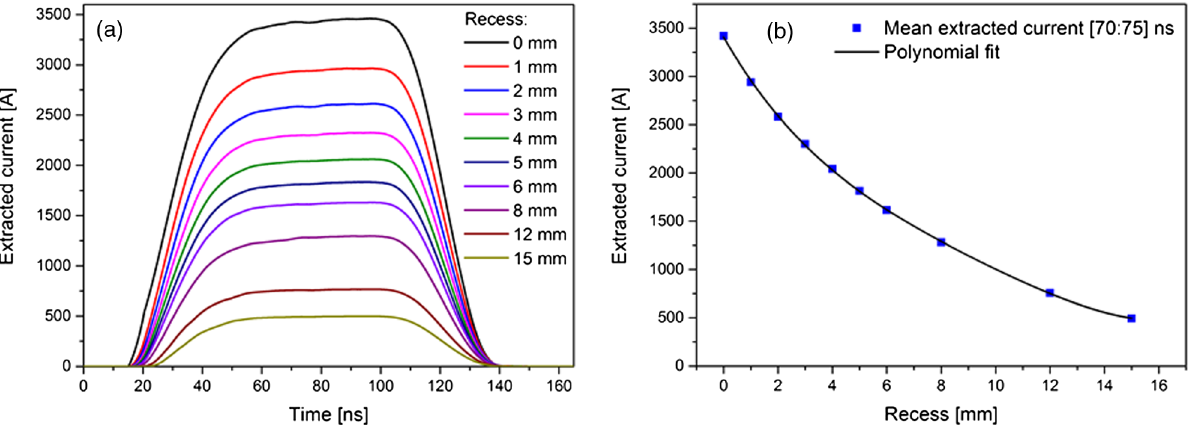
FIG. 4. (a) Simulated electron beam current at BPM 1 as a function of time for different recess values. (b) Simulated mean beam current over [70 – 75] ns range as a function of recess (blue square) and fourth order polynomial fit (black curve): current ¼ 3408 . 08 − 491 . 40 ð recess Þ þ 47 . 76 ð recess Þ 2 − 3 . 07 ð recess Þ 3 þ 0 . 08 ð recess Þ 4